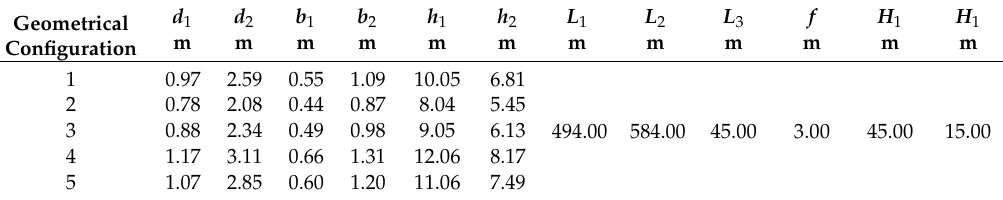
Table 1. Geometric dimensions of the pedestrian